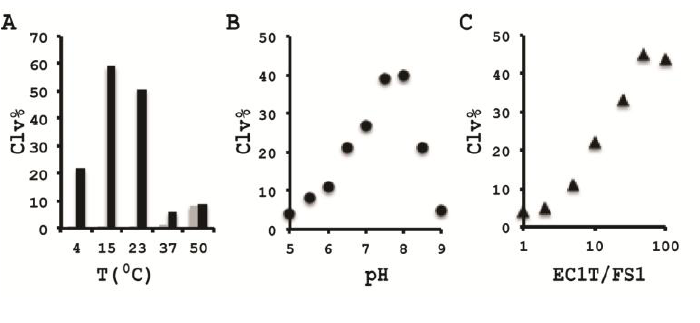
Figure 4. Cleavage activity of EC1T/FS1 with varying temperature ( A ), pH ( B ), and EC1T/FS1 ratio ( C ). The data are the average of two independent